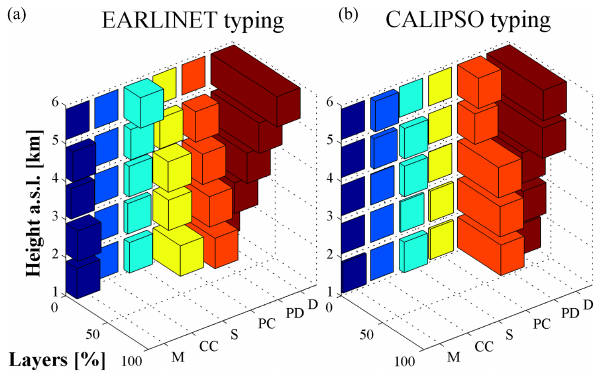
Figure 7. Granada: (a) EARLINET and (b) CALIPSO typing bar- plots for 1km range increment. M stands for marine, D for dust, PC for polluted continental, CC for clean continental, PD for polluted dust, and S for smoke